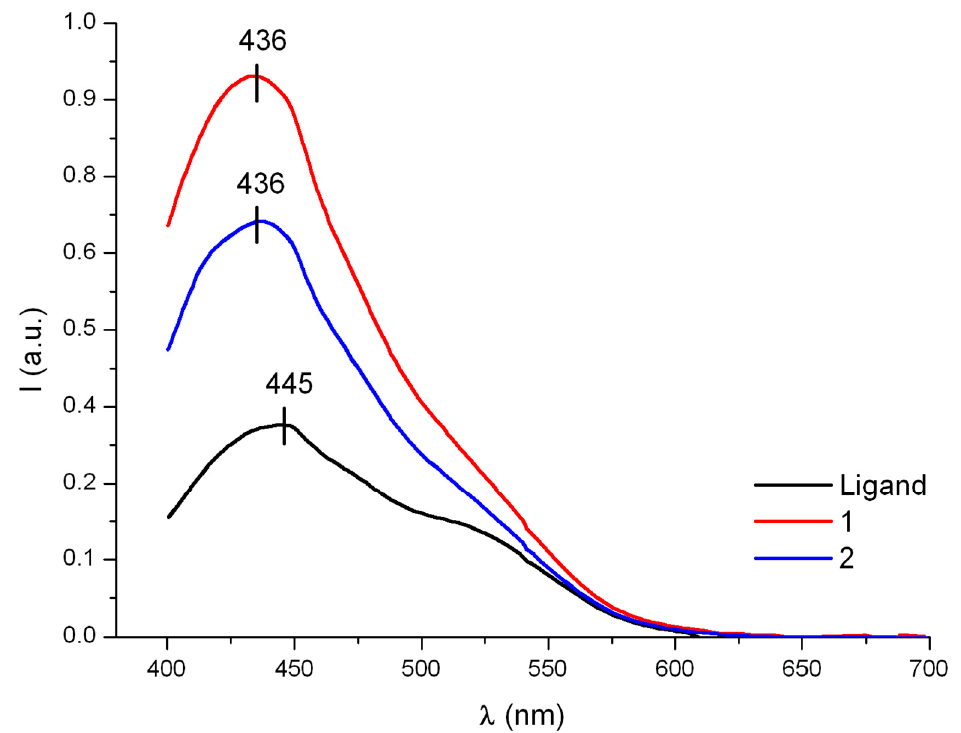
Figure 6. Emission spectra of the sodium salt of the ligand and the Zn 2+ and Cd 2+ complexes, all three in solid state.